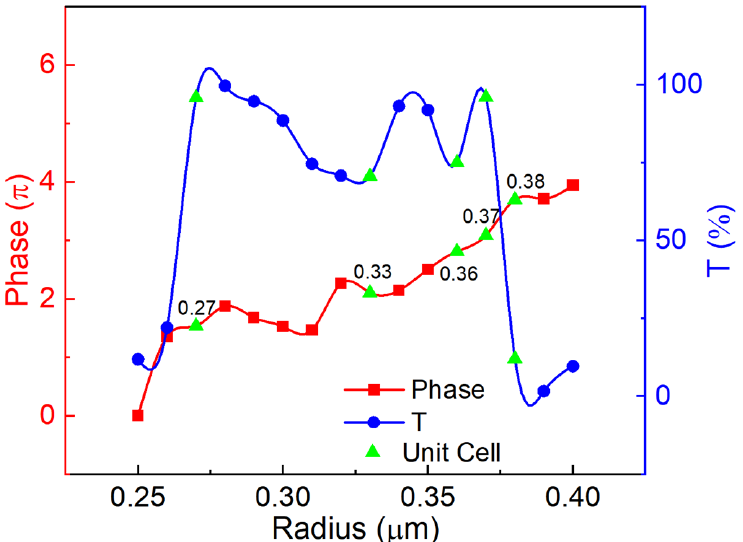
Figure A1. The phase (red line) and transmittance curves (blue line) of outgoing light at 1.55 µ m wavelength when the nanocolumn radius changes from 0.25 µm to 0.40 µm. The radius dimension points of the selected metasurface unit cell structure are marked in green. The above figure represents the transmittance and phase variation of different radius unit cells of the metasurface, and the overall results of the final metasurface are also based on the transmittance and phase characteristics of the unit cell. It can be seen that at several structural parameters selected in this paper (0.27 µ m, 0.33 µ m, 0.36 µ m, 0.37 µ m, and 0.38 µ m), the simulation results of the FDTD method and the FIT method have similar transmittance and phase variation, so the overall metasurface composed of unit cells will also produce similar